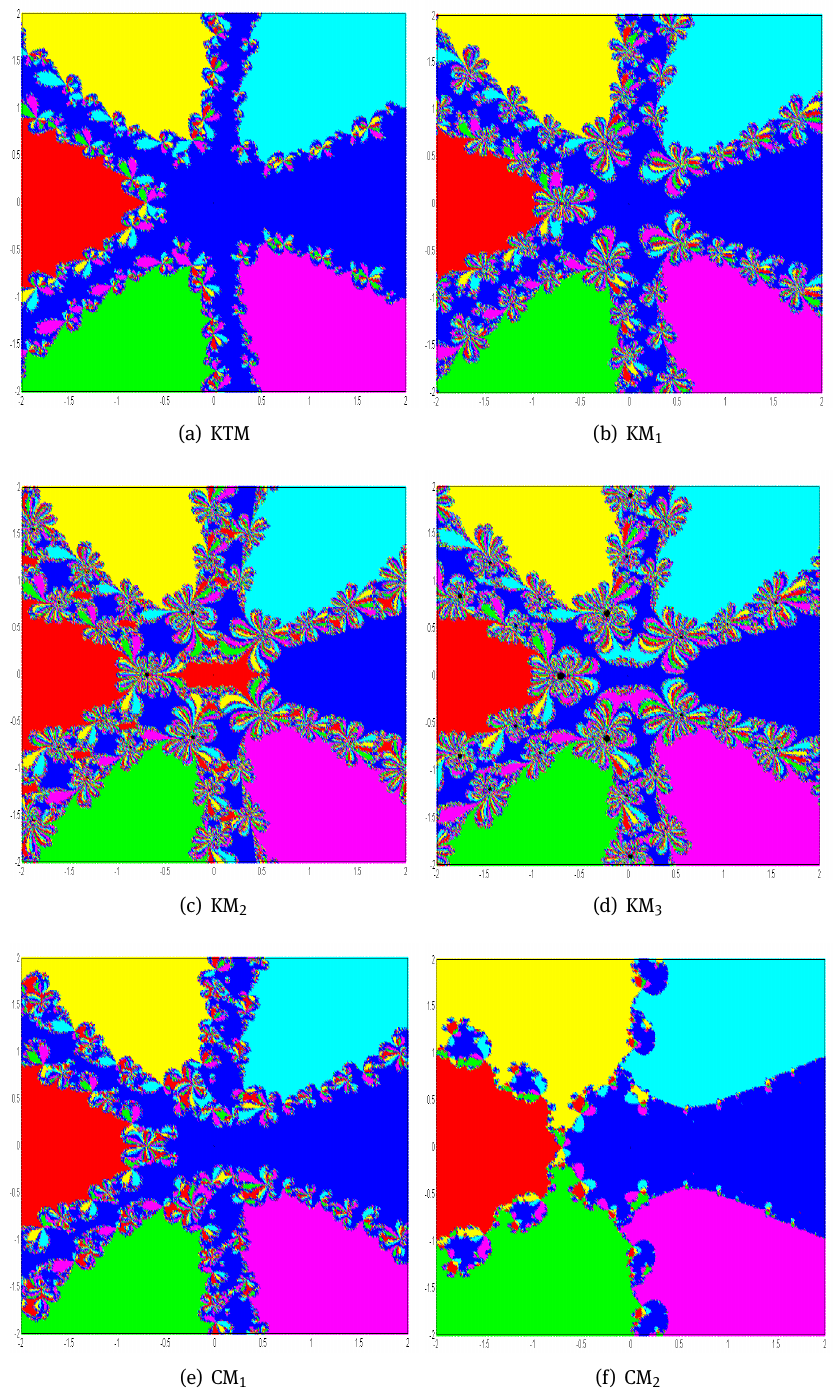
Figure 7: Basins of attraction of the methods KTM, KM 1 , KM 2 , KM 3 , CM 1 and CM 2 respectively for P 3 ( z ) = z 6 + z − 1